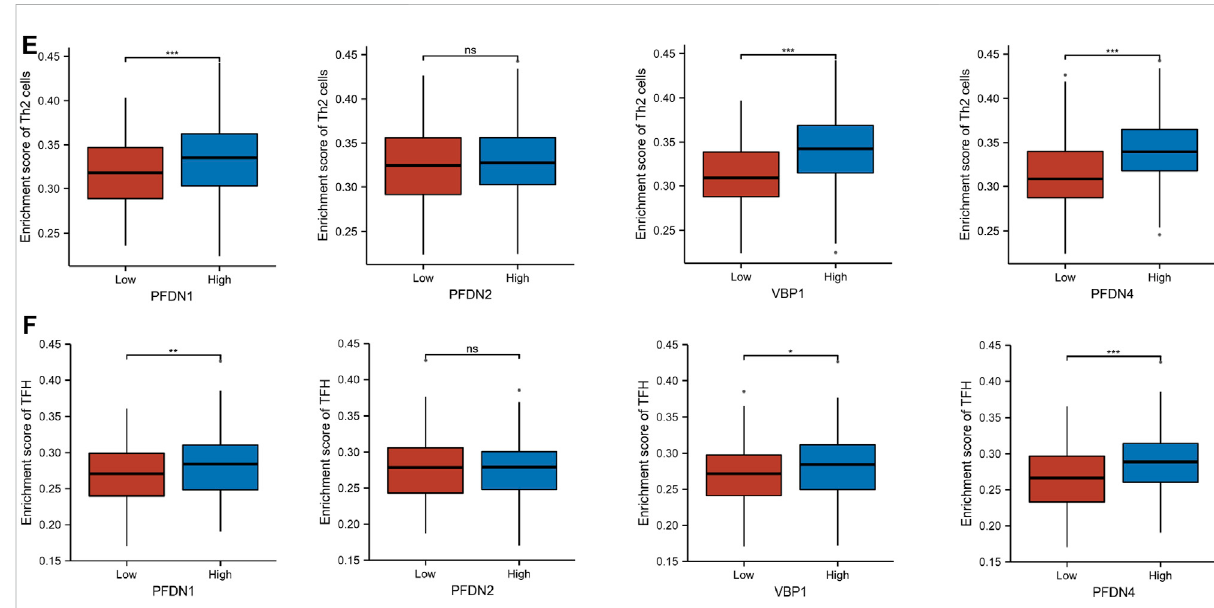
FIGURE 4 Expression of PFDN1/2/3/4 was related to immune in fi ltration of the tumor microenvironment. (A – D) Relationships between PFDN1/2/3/ 4 expression and relative abundances of 24 immune cells. (E,F) Differential enrichment of TFH and Th2 cells in PFDN1-/2-/3-/4-high groups compared with PFDN1-/2-/3-/4-low groups,